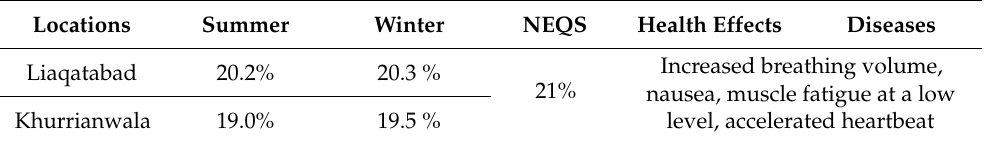
Table 5. Seasonal variation of O 2 at selected sites in comparison to NEQS and corresponding health effects.